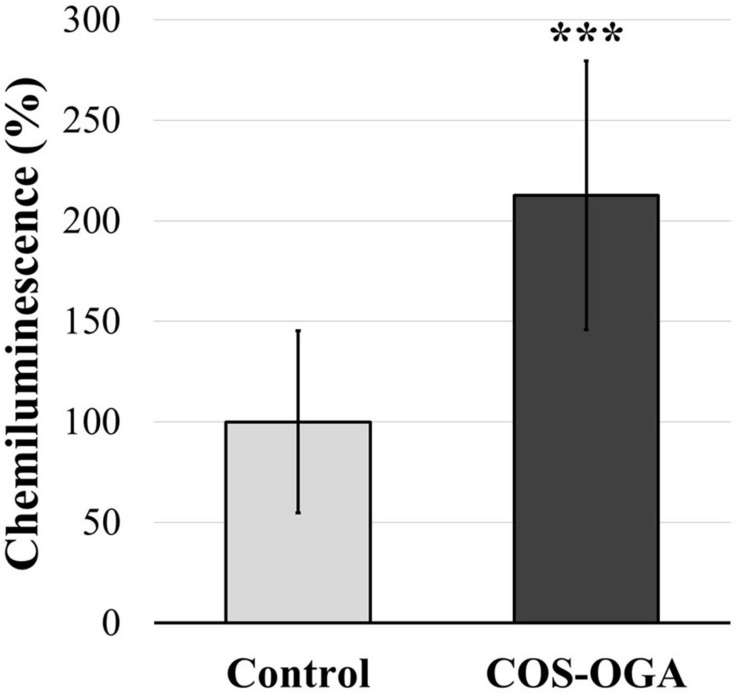
Normalized apoplastic reactive oxygen species (ROS) production in tomato leaf disks. Tomato leaf disks were treated with 0.1% Tween 20 (control) or chitooligosaccharides–oligogalacturonides (COS-OGA; 62.5 mg/l). The average apoplastic ROS production of the COS-OGA-treated leaf disks is expressed as a percentage luminol chemiluminescence emitted in comparison to the control ± standard deviation (n = 12). ***indicates a statistically significant difference to control according to Student’s t test (p < 0.001, R).